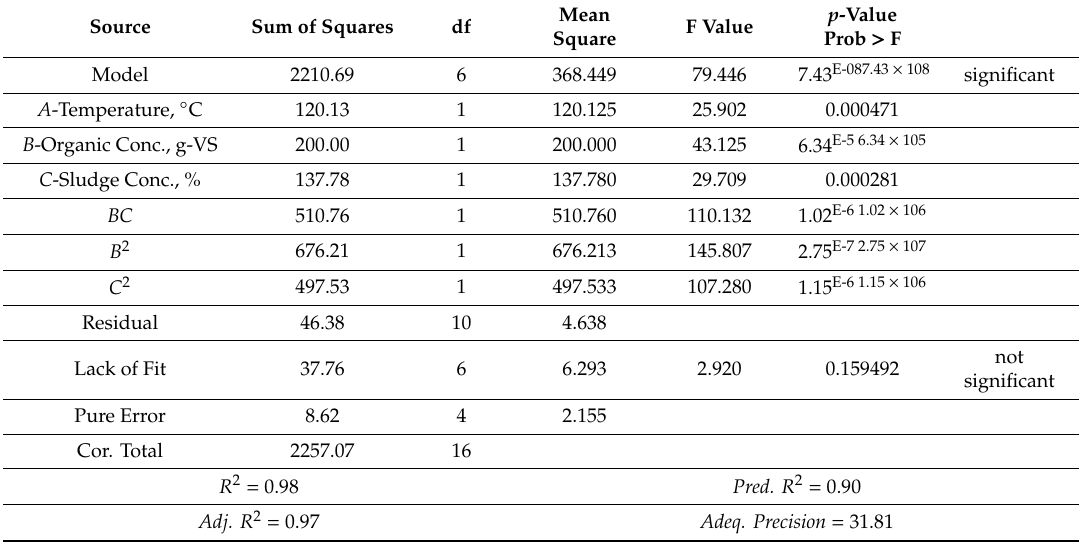
Table 7. The ANOVA table for CH 4 %